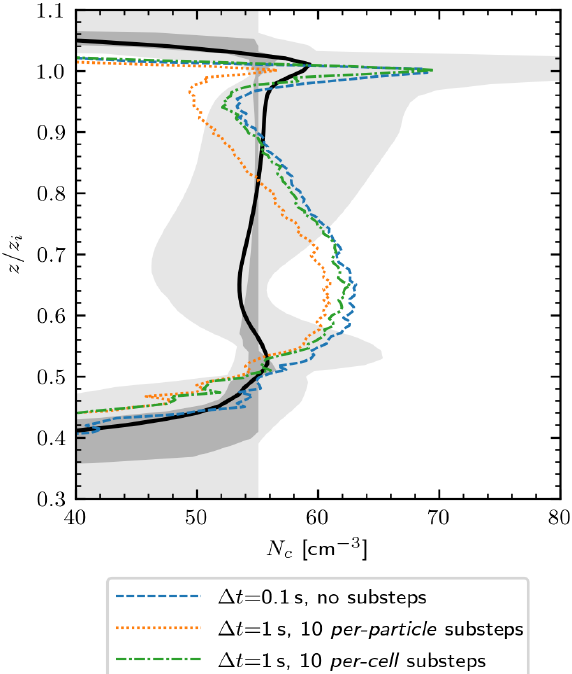
Figure B1. Vertical profiles of the concentration of cloud droplets from the 2-D piggybacking simulations with different substep- ping algorithms, averaged over the 2–4h period. The black line and shaded regions show results from Ackerman et al. (2009) (cf. Fig.